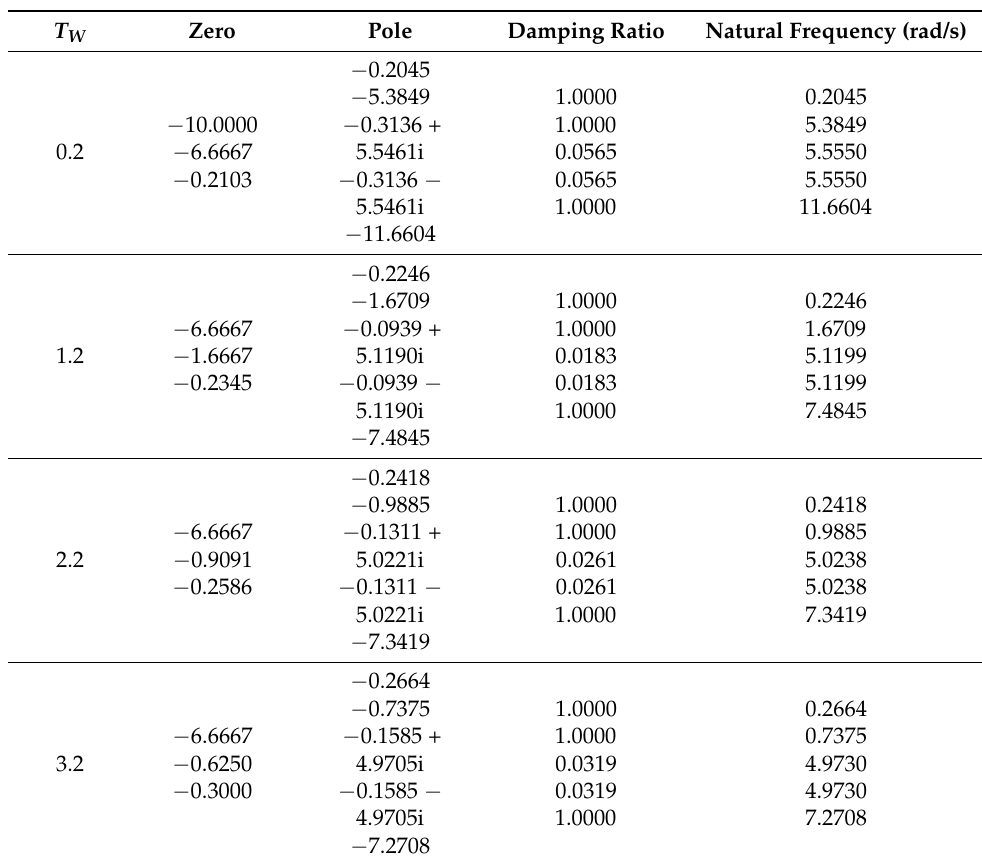
Figure 6. Block diagram of PRM. Table 3. The parameters in